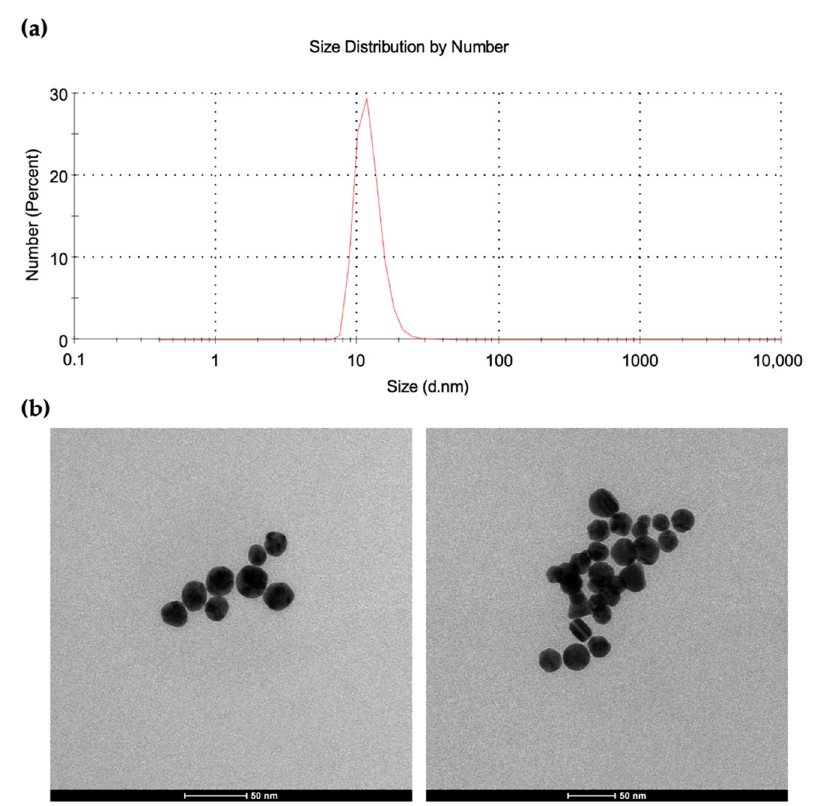
Figure 2. ( a ) DLS image and ( b ) TEM image of